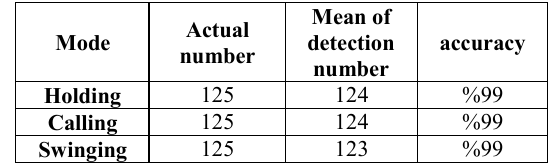
Table 5. Results of the step detection algorithm